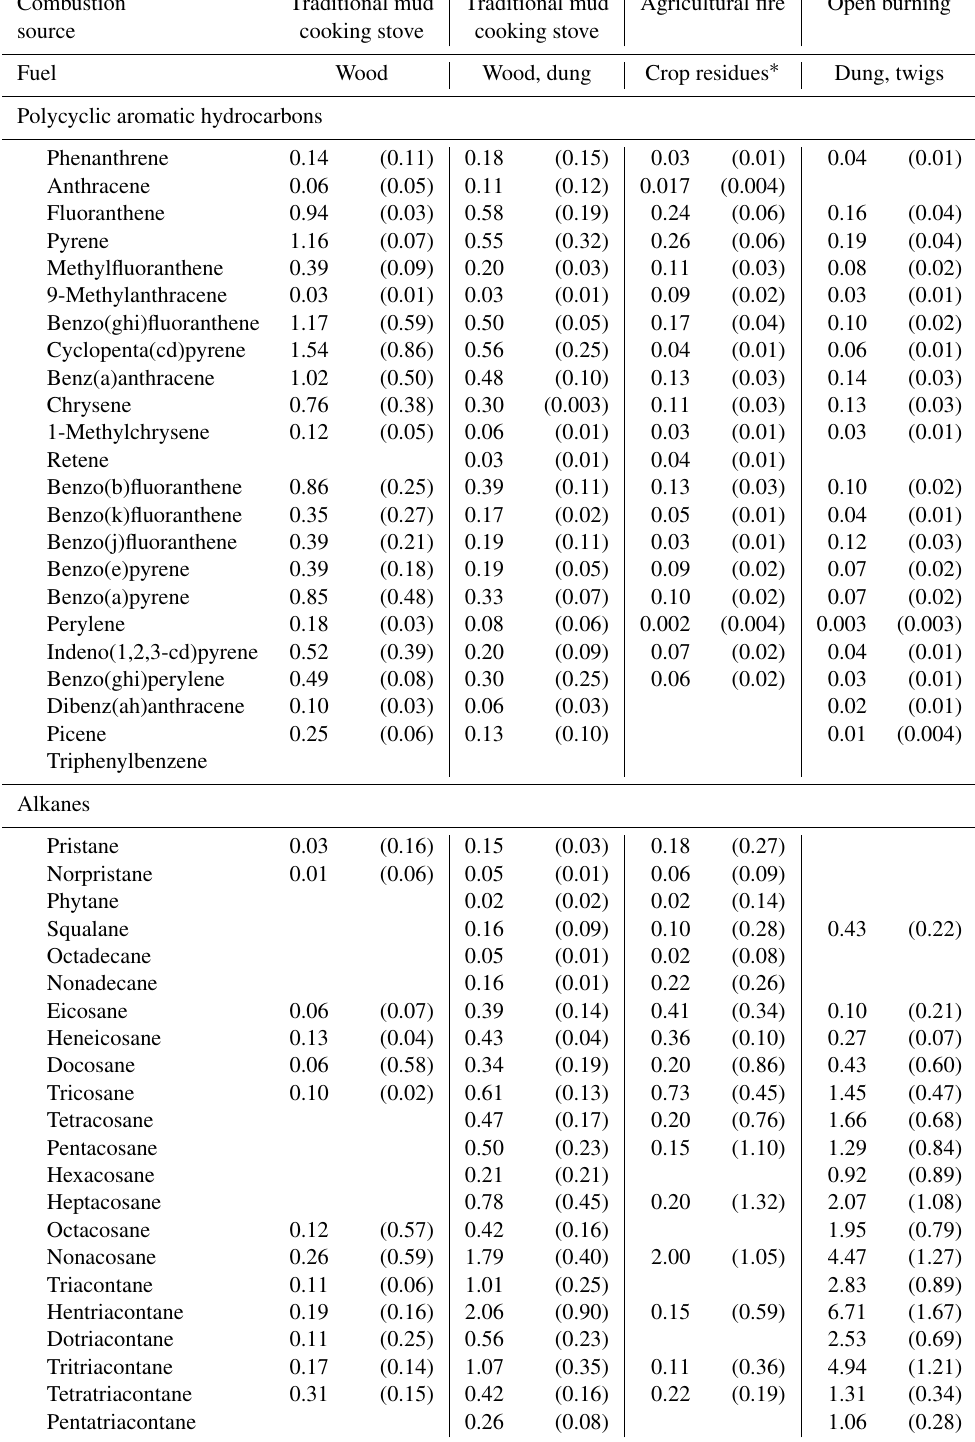
Table 4. Summary of emissions data for biofuel combustion sources with respect to organic species normalized to organic carbon mass (mgg OC − 1 ) . Tricyclic terpanes were not detected. Errors are shown in parentheses; a description of their calculation is provided in Sect. 3. Missing values are below the method detection limits, which are provided sample by sample in Table